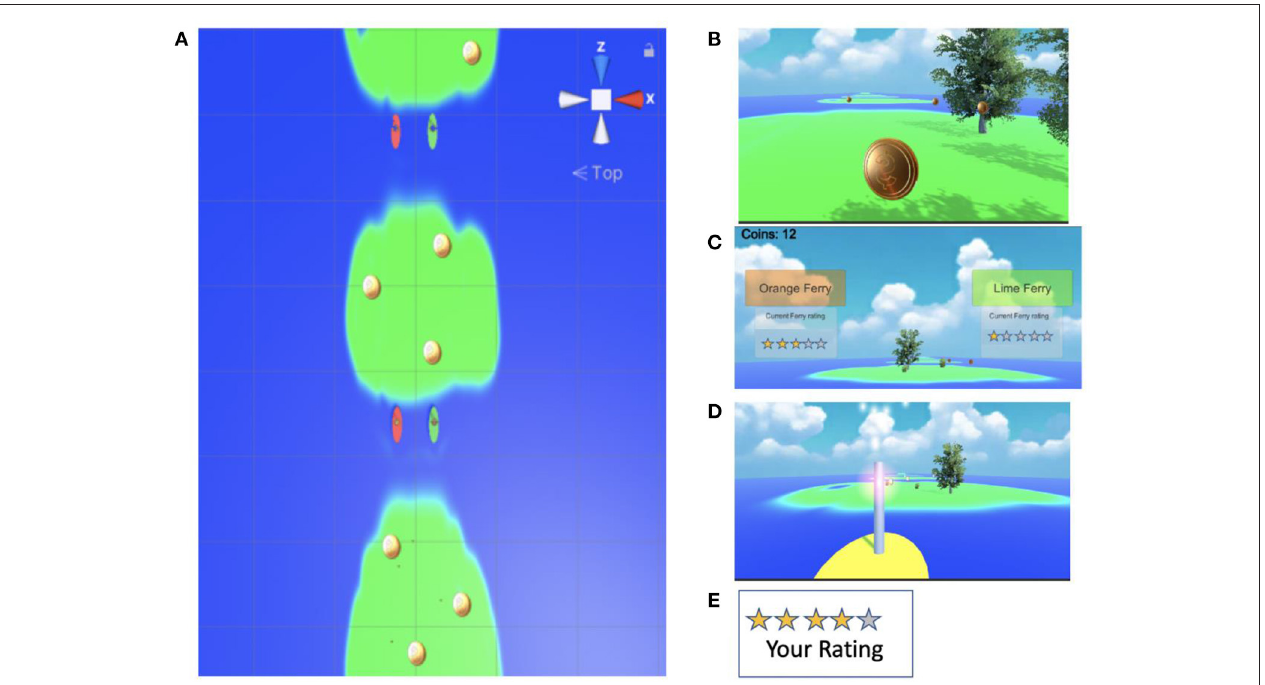
FIGURE 3 | Ferry Services Game. (A) A 3D virtual environment composed of islands with coins scattered in different locations. (B) Collecting coins in each island. (C) Ferry services are used to cross between islands. Dashboard represents ferry rating scores. (D) Ferry services differ in speed and delays. (E) At the end of each ride player might be prompted to rate ferry performance.